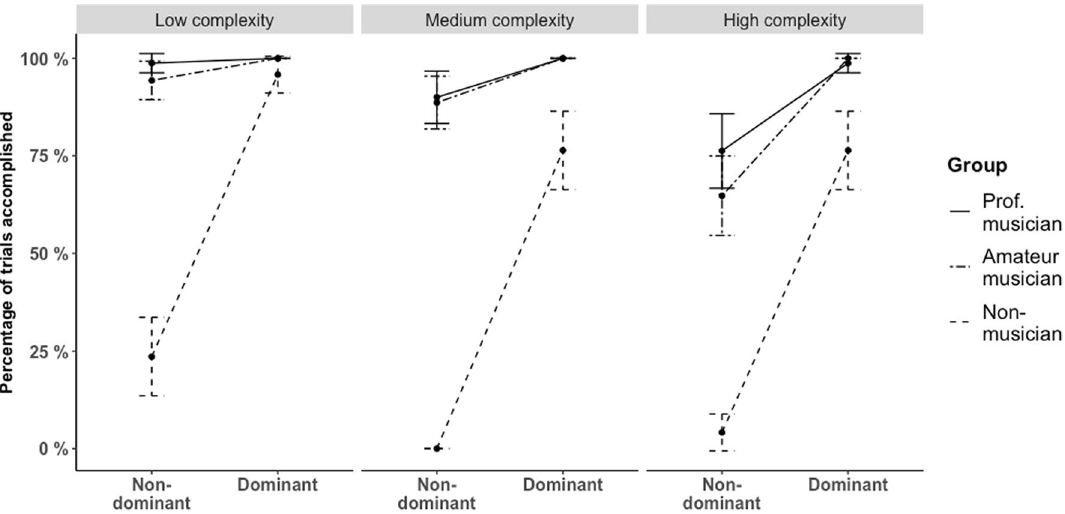
Figure 4. The percentage of accomplished trials. Split in subtests and expertise groups, showing only combinations including the voice. Vertical bars represent 95% confidence